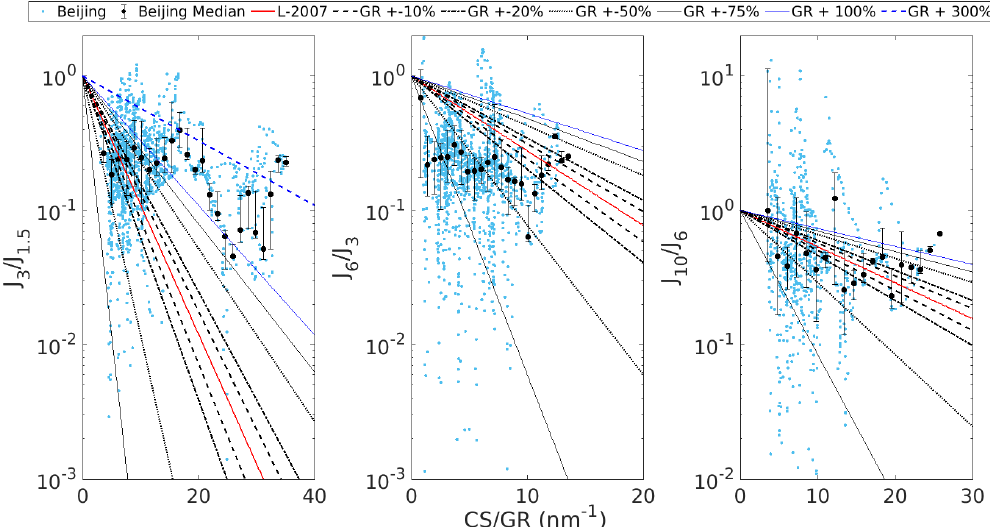
Figure 11. Survival probabilities from 1.5 to 3nm ( J 3 /J 1 . 5 ), from 3 to 6nm ( J 6 /J 3 ), and from 6 to 10nm ( J 10 /J 6 ) as a function of the ratio of condensation sink and growth rate (CS / GR). Survival probabilities based on the Lehtinen et al. (2007) equation with varying error of GR are presented. The observed survival probabilities from Beijing, China, are shown with their median values marked in